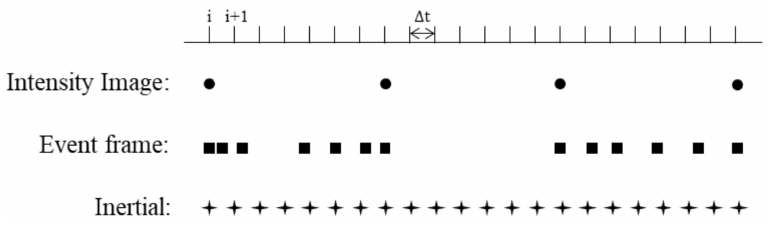
Figure 1. Different frequency of intensity images, event frames, and inertial updates.